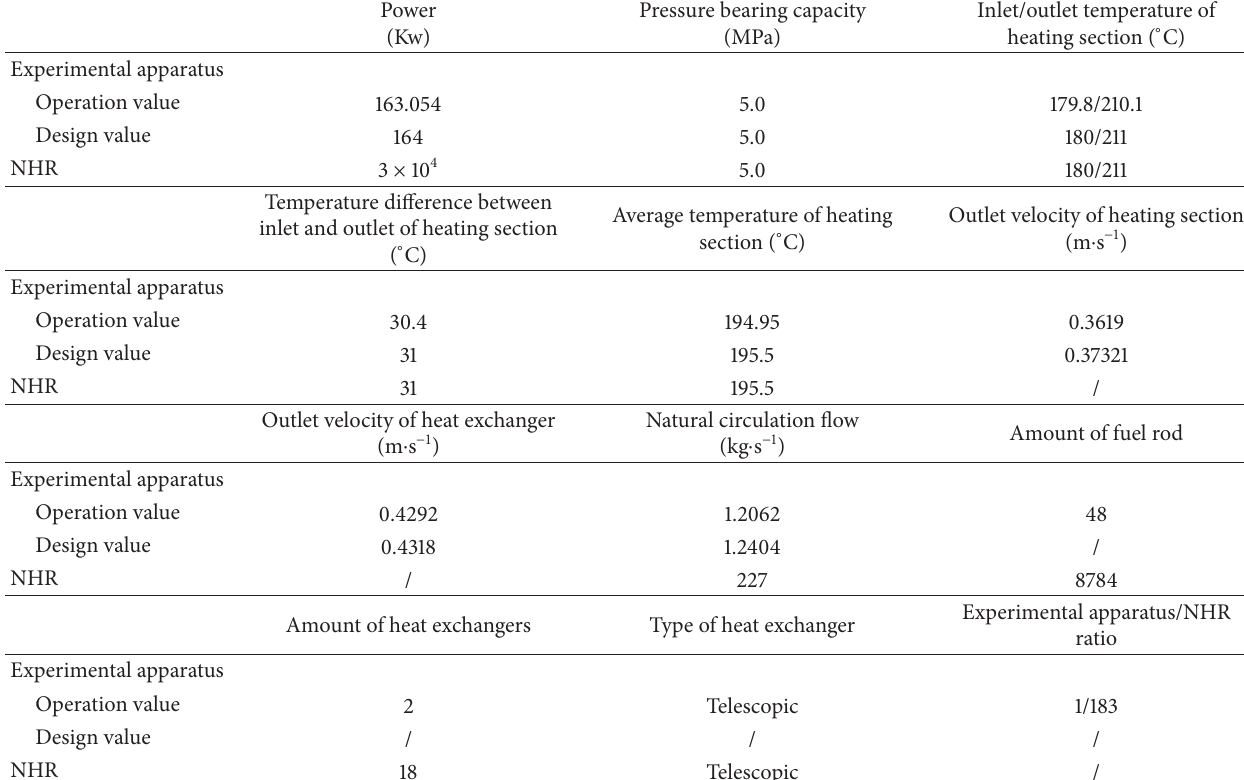
Table 1: Comparison of operation parameters of experimental apparatus and